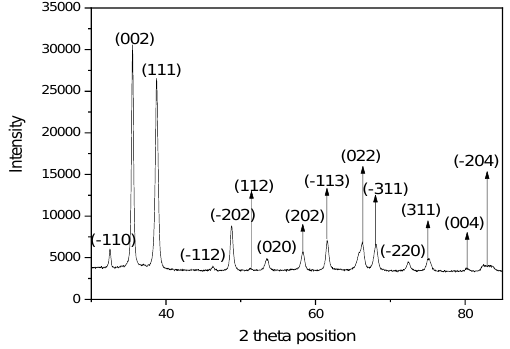
Figure 1. XRD Spectrum of B. ciliate mediated CuO NPs.